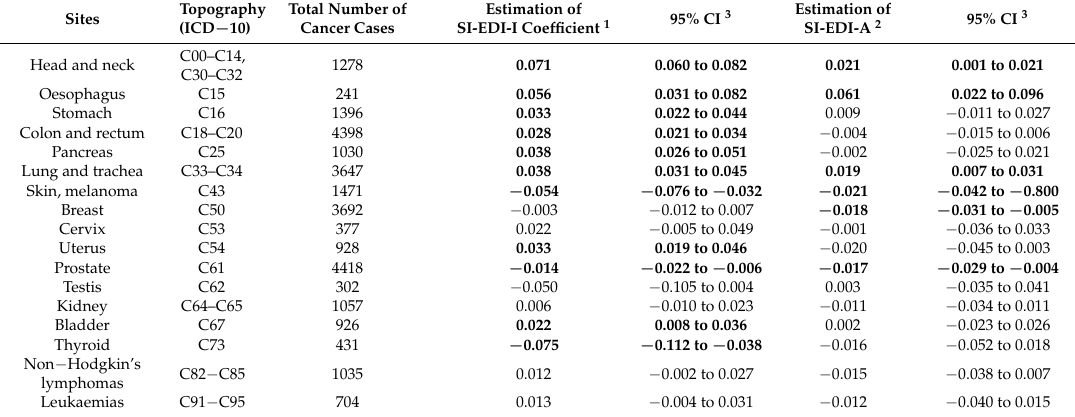
Table 5. Association of socio-economic deprivation at individual and aggregated level and cancer incidence in Slovenia between 2011 and 2013.